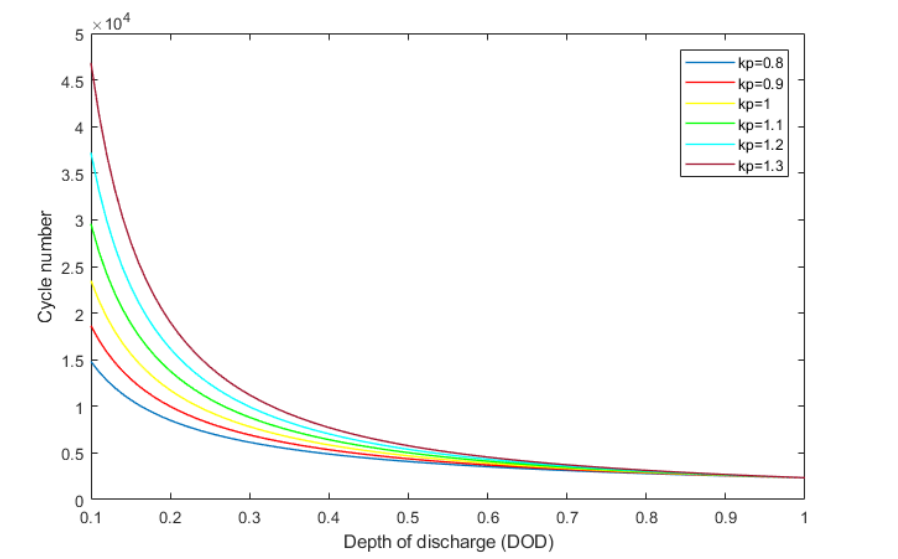
Figure 2. Maximum number of cycles the battery can experience at different